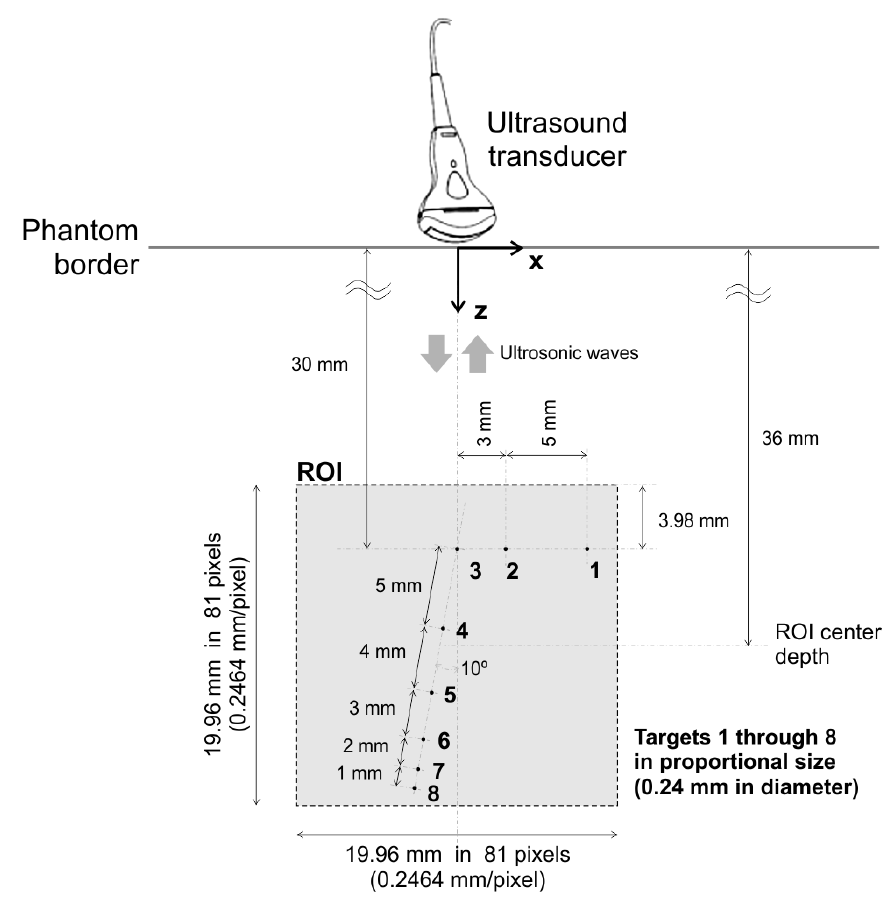
Figure 7. Schematic view of targets inside the phantom. Dimensions, sizes and relative positions as detailed in [70]. This picture is not present in the cited